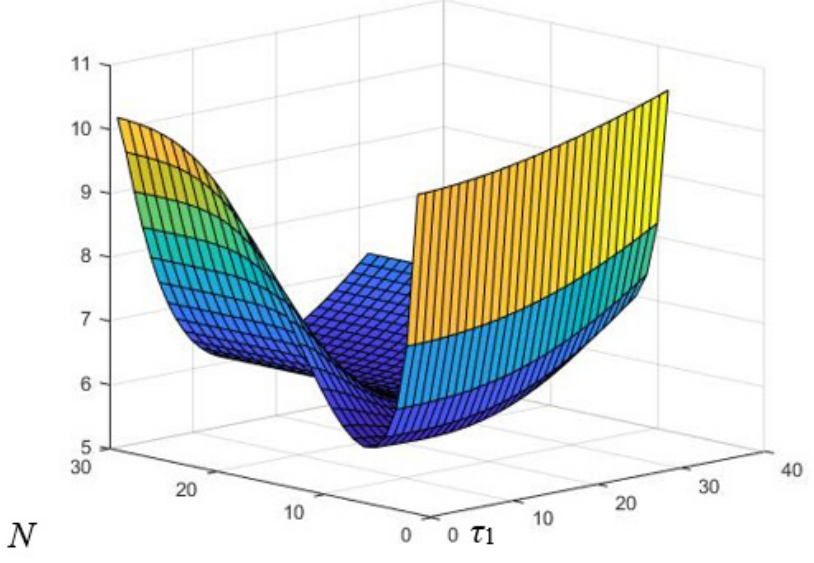
Figure 6. The plot of C 2 ( τ 1 , N ) against τ 1 and N .